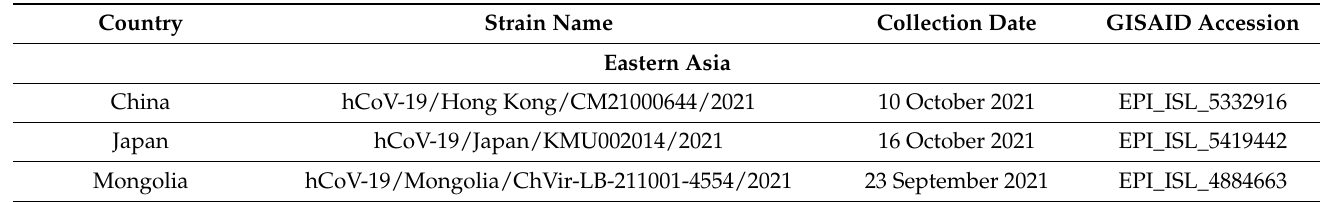
Table 4. Most recent reported occurrences in different countries on the Asian continent according